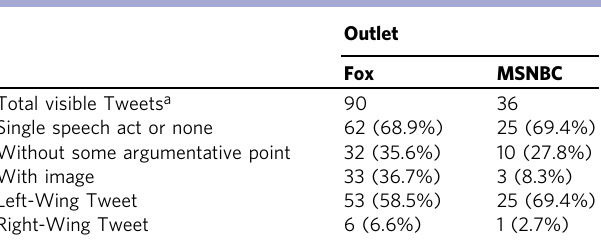
Table 2 Characteristics of tweets as a unit of